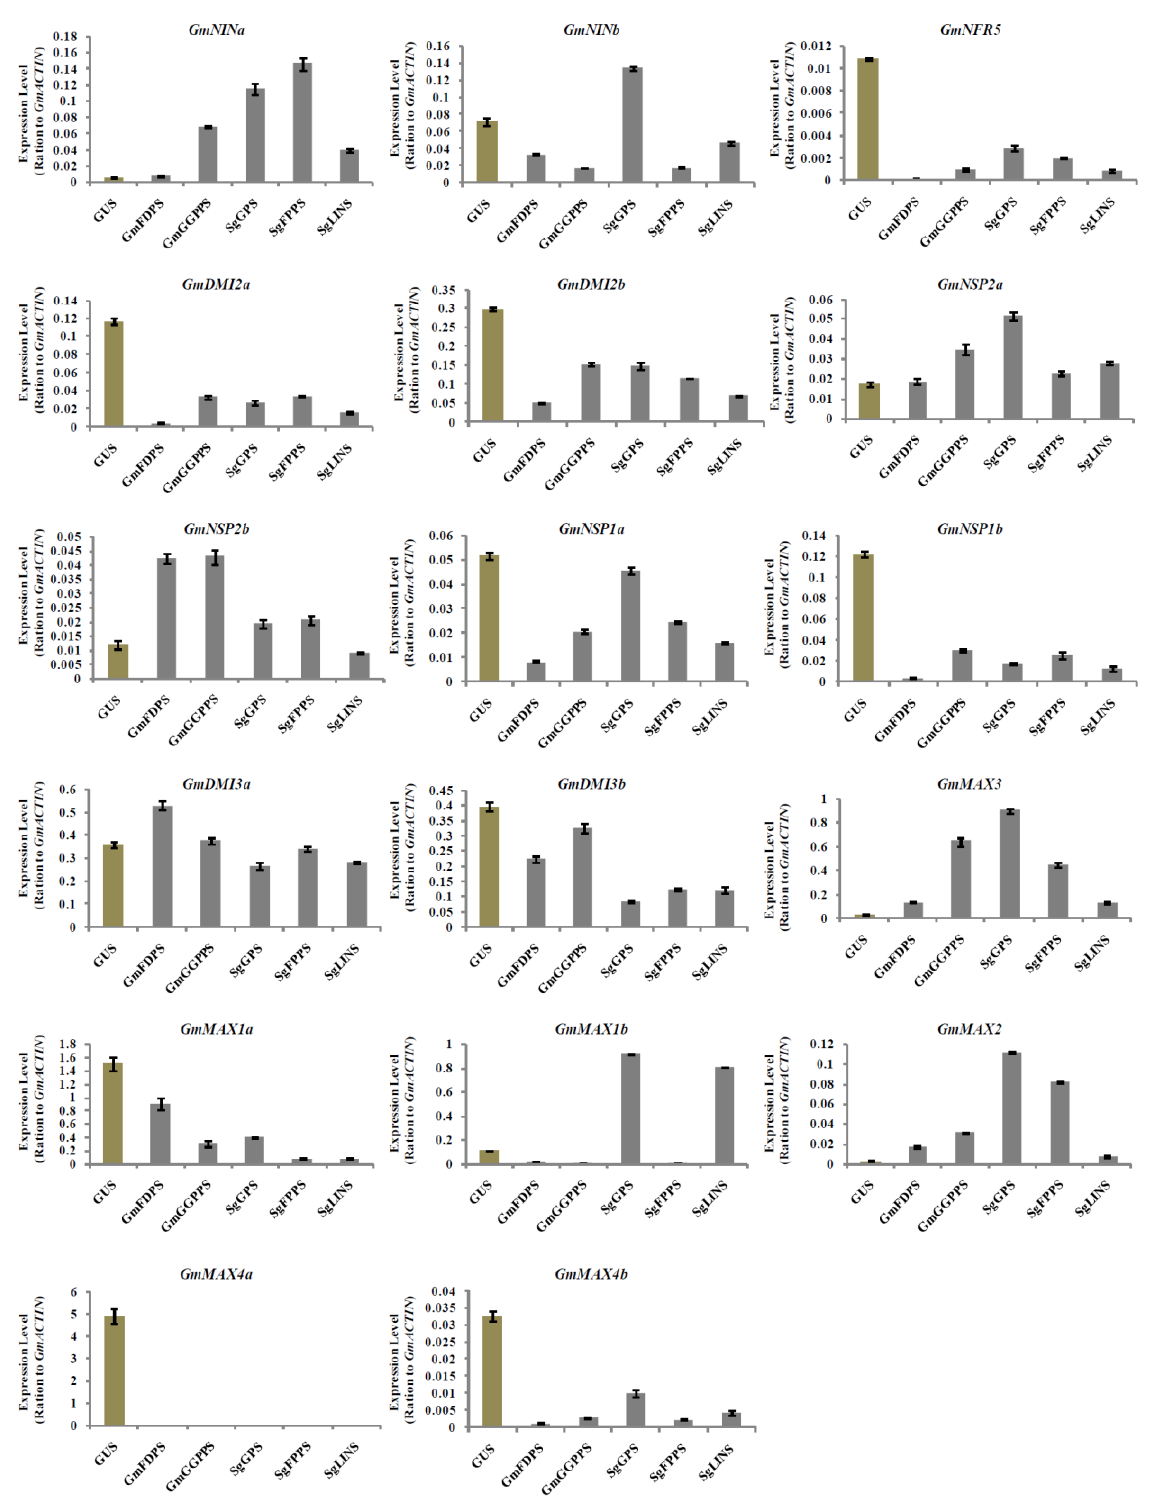
Figure 7. Expression profiles of SL biosynthesis and nodulation genes in soybean transgenic hairy roots after 20 days of rhizobia inoculation. Gene expression was analyzed using quantitative real-time PCR compared to GUS as a control. The housekeeping GmB-ACTIN gene was used as an internal reference gene for expression normalization. The error bars indicate the SD of three qRT-PCR biological replicates.